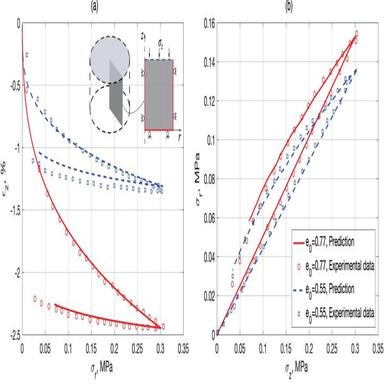
Comparison between numerical predictions and experimental measurements of oedometer tests.